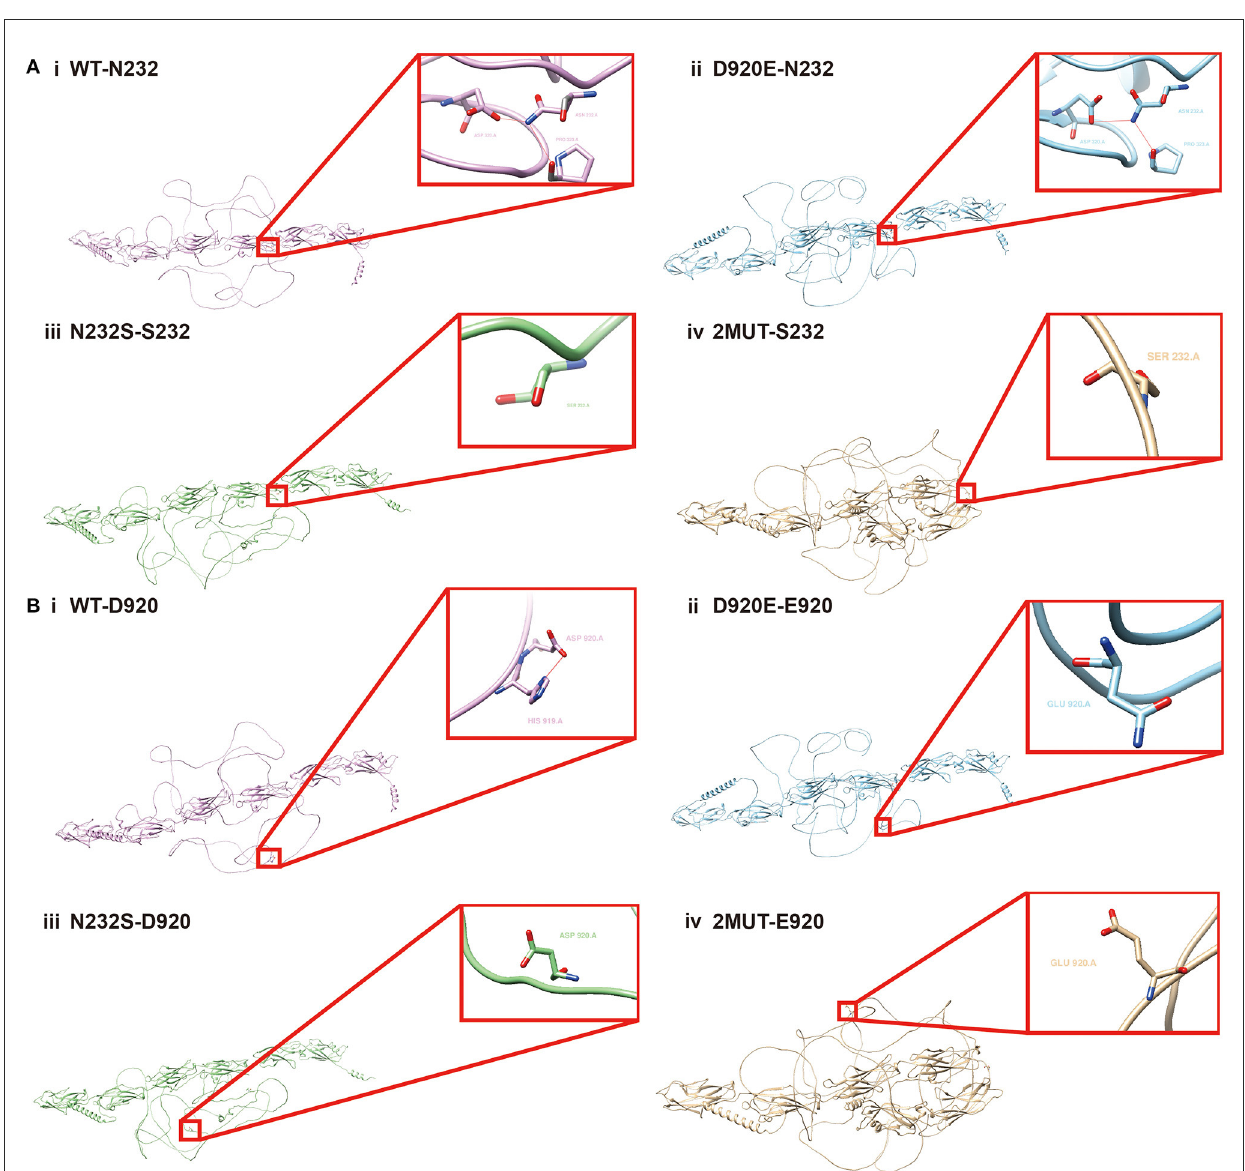
FIGURE3 Structural alteration analysis of PCDH19 protein by Alphafold2. N232S in the figure symbolizes Asn at the 232 amino acid position of PCDH19 protein mutates to Ser, and the D920E represents the Asp at the 920 position mutates to Glu. (A) The PCDH19 protein structure prediction and partially amplified conformation of the 232 amino acid position on PCDH19 protein under the condition of (i) wild type, (ii) D920E, (iii) N232S, and (iv) the concurrent D920E and N232S mutation were exhibited. (B) The PCDH19 protein structure and partially amplified conformation of 920 amino acid position on the PCDH19 protein under the condition of (i) wild type, (ii) D920E, (iii) N232S, and (iv) D920E and N232S mutation coexistence were also